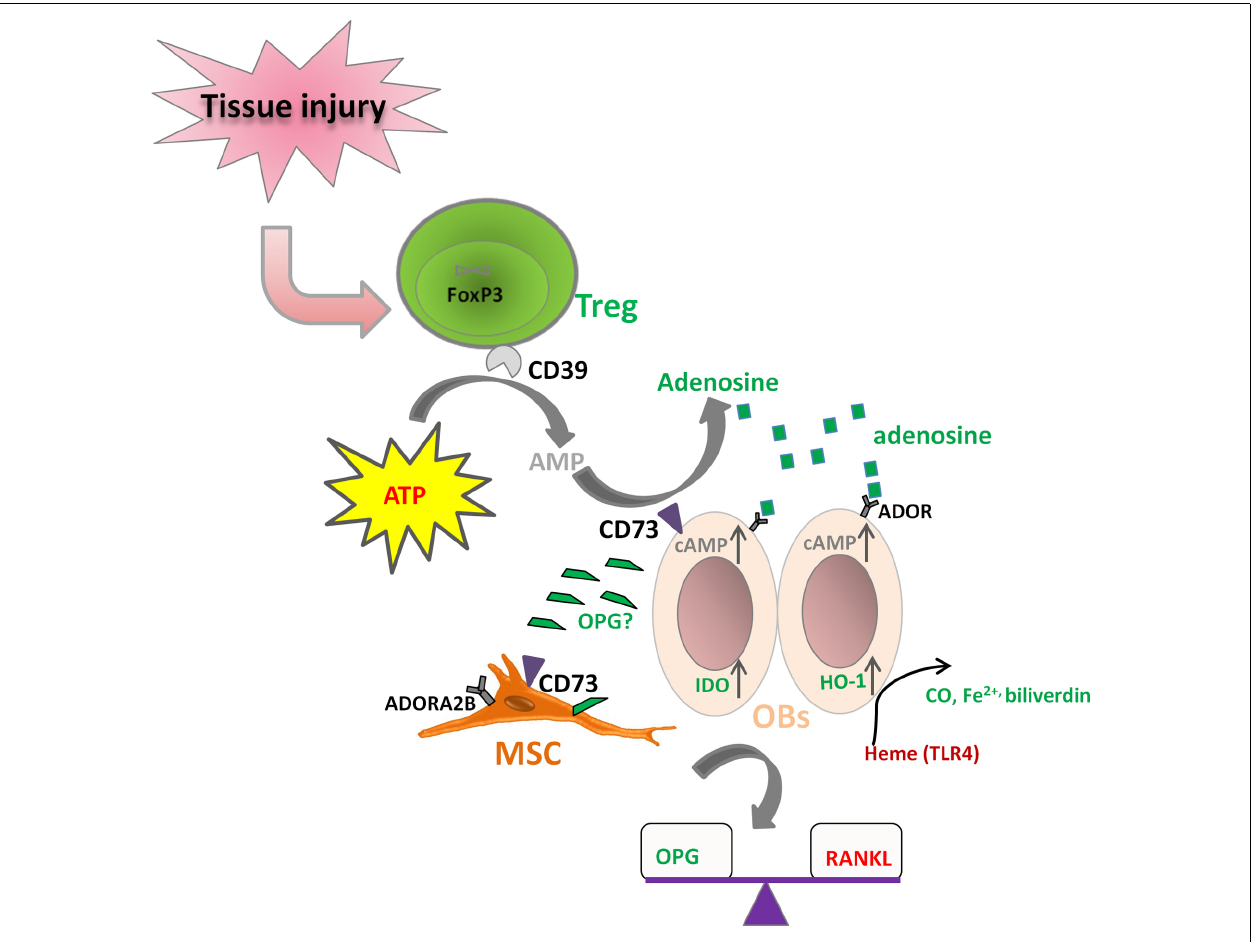
FIGURE 3 | Hypothesized direct cross-talk between Treg and osteoblasts (MSCs). (i) CD39 expressing Treg may co-operate with CD73 expressing osteoblasts (MSCs) to hydrolyze ATP to form adenosine, which can further bind to its receptor on osteoblasts (ADOR) to trigger the inhibitory pathways; (ii) Treg may up-regulate IDO and HO-1 expression on osteoblasts; (iii) Treg play a role in the balance of RANKL/OPG, thus facilitating osteoblast